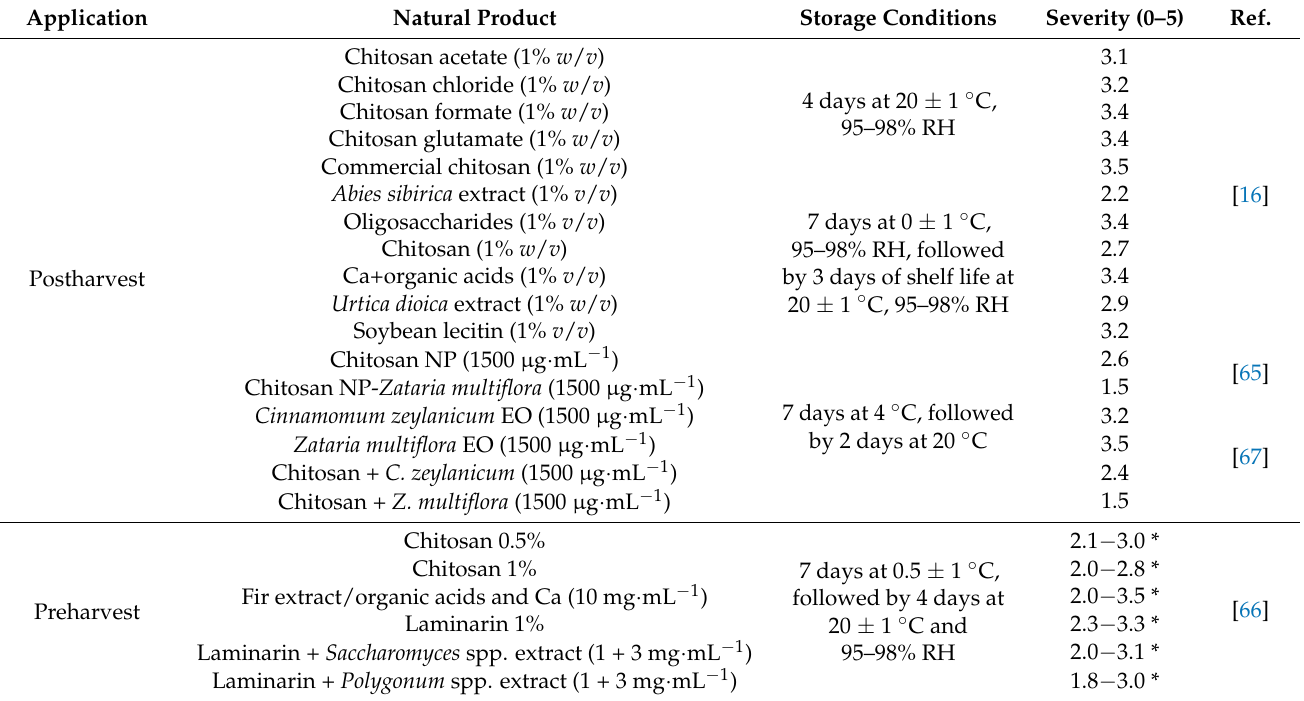
Table 8. Treatments with chitosan and other alternatives to conventional fungicides to control gray mold decay of strawberry reported in the literature and their associated decay